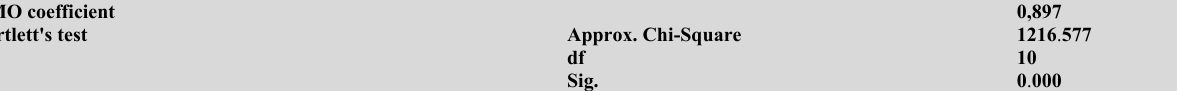
KMO coefficient and Bartlett's test of the dependent variable